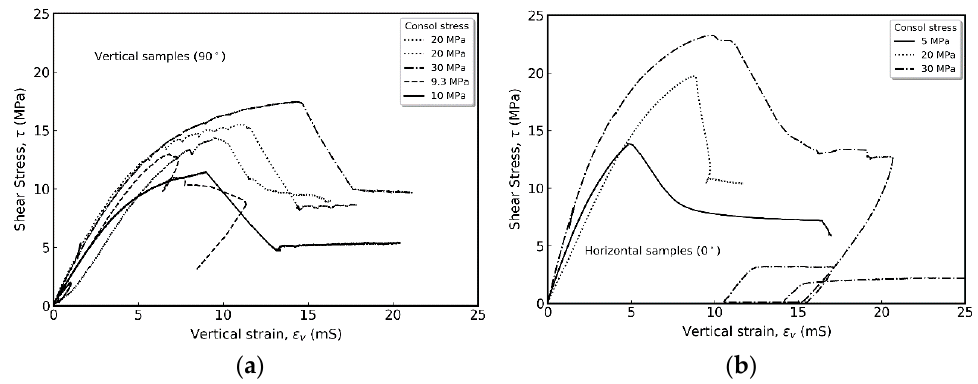
Figure 10. Shear stress versus vertical strain during undrained shearing for vertical ( a ) and horizon- tal ( b ) samples.